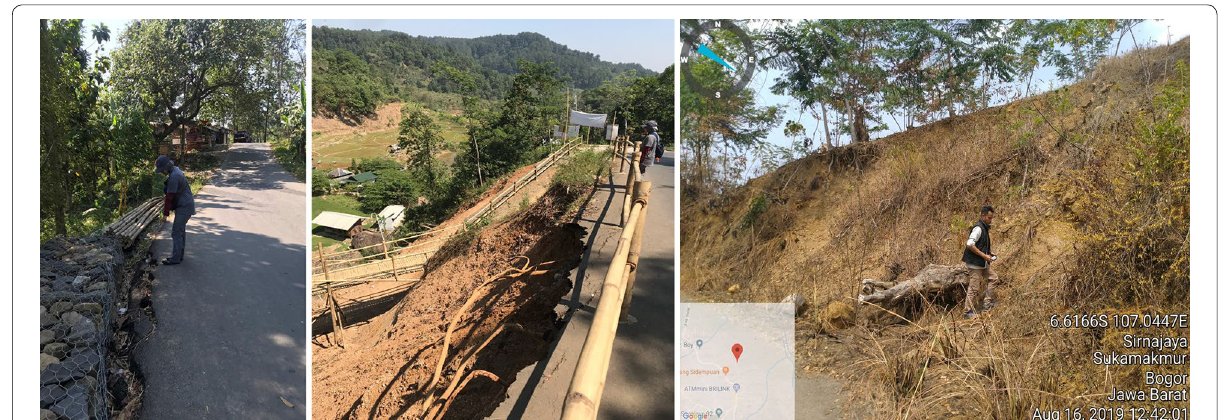
Fig. 2 Example of landslide events in Bogor, West Java,